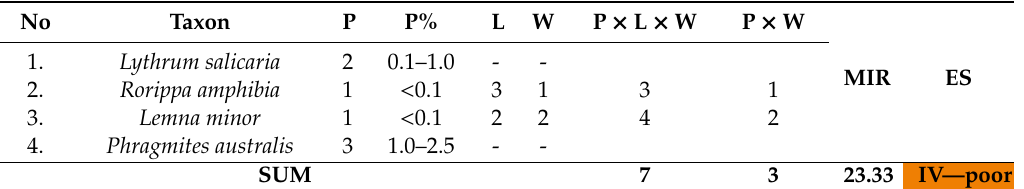
Table 7. Summary of MMOR results, May 2017, section above the barrage on the ´Sl˛eza.